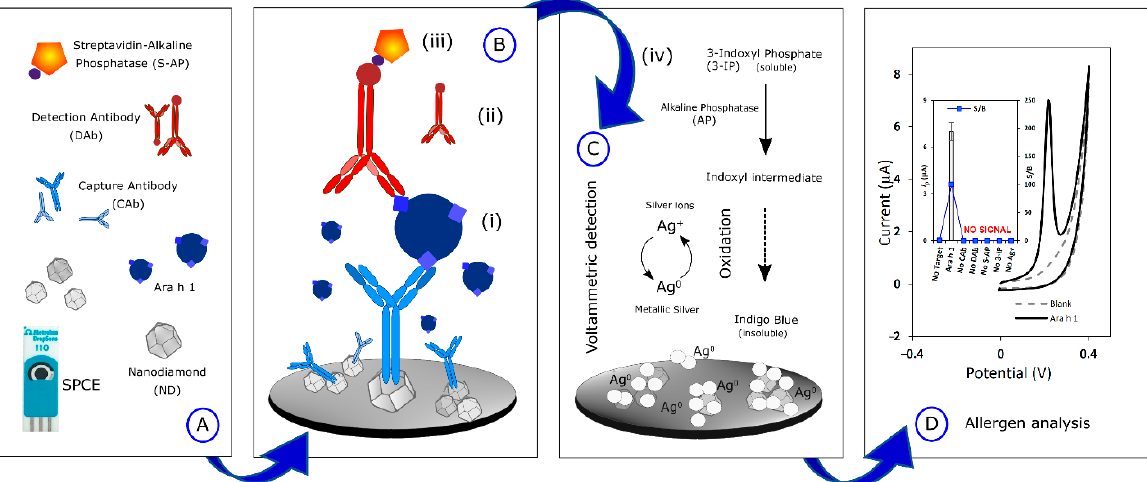
Figure 1. Schematic illustration of the analysis of Arachis hypogaea allergen. ( A ) SPCE nanostructuration with NDs, ( B ) Sandwich-type voltammetric immunosensor construction, ( C ) Metalloenzymatic reaction, ( D ) Linear Sweep voltammograms of the silver particles (inset: evaluation of the immunoassay performance in the presence of the target analyte (Ara h 1) and the absence of several of the assay´s reagents.